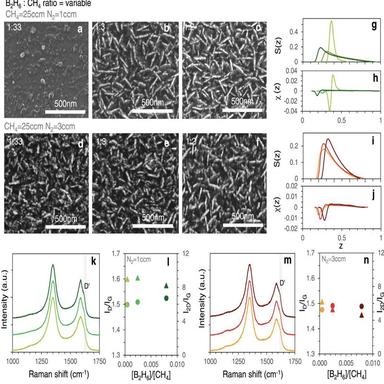
(a–f) SEM, (g–j) MFs, (k,m) Raman spectra, (l,n) ID/IG and I2D/IG ratios of three samples grown at a variable B2H6/CH4 ratio.